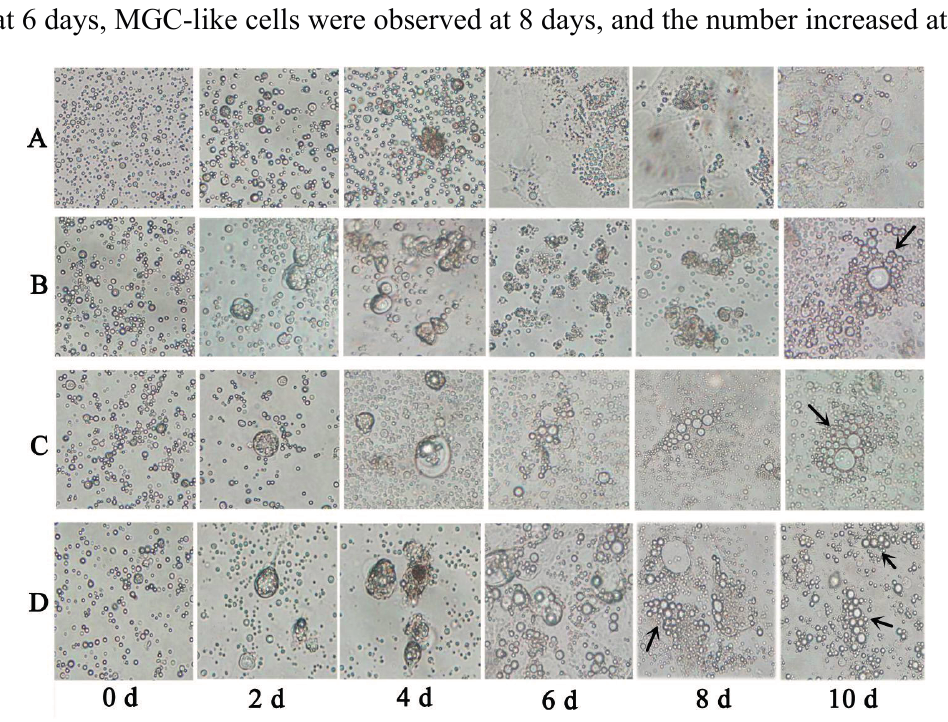
Figure 2. Differentiation of chicken embryonic stem cells (ESCs) induced by different DAZL inducers. ( A ) chicken ESCs with DMEM; ( B ) chicken ESCs with 10 − 5 mol/L l-trans retinoic acid (ATRA) induction; ( C ) chicken ESCs with 10 − 6 mol/L Am800 induction; ( D ) chicken ESCs with 1 μ g/mL E 2 induction. Arrows represent spermatogonial stem cell-like (SSC-like) cells. (400×